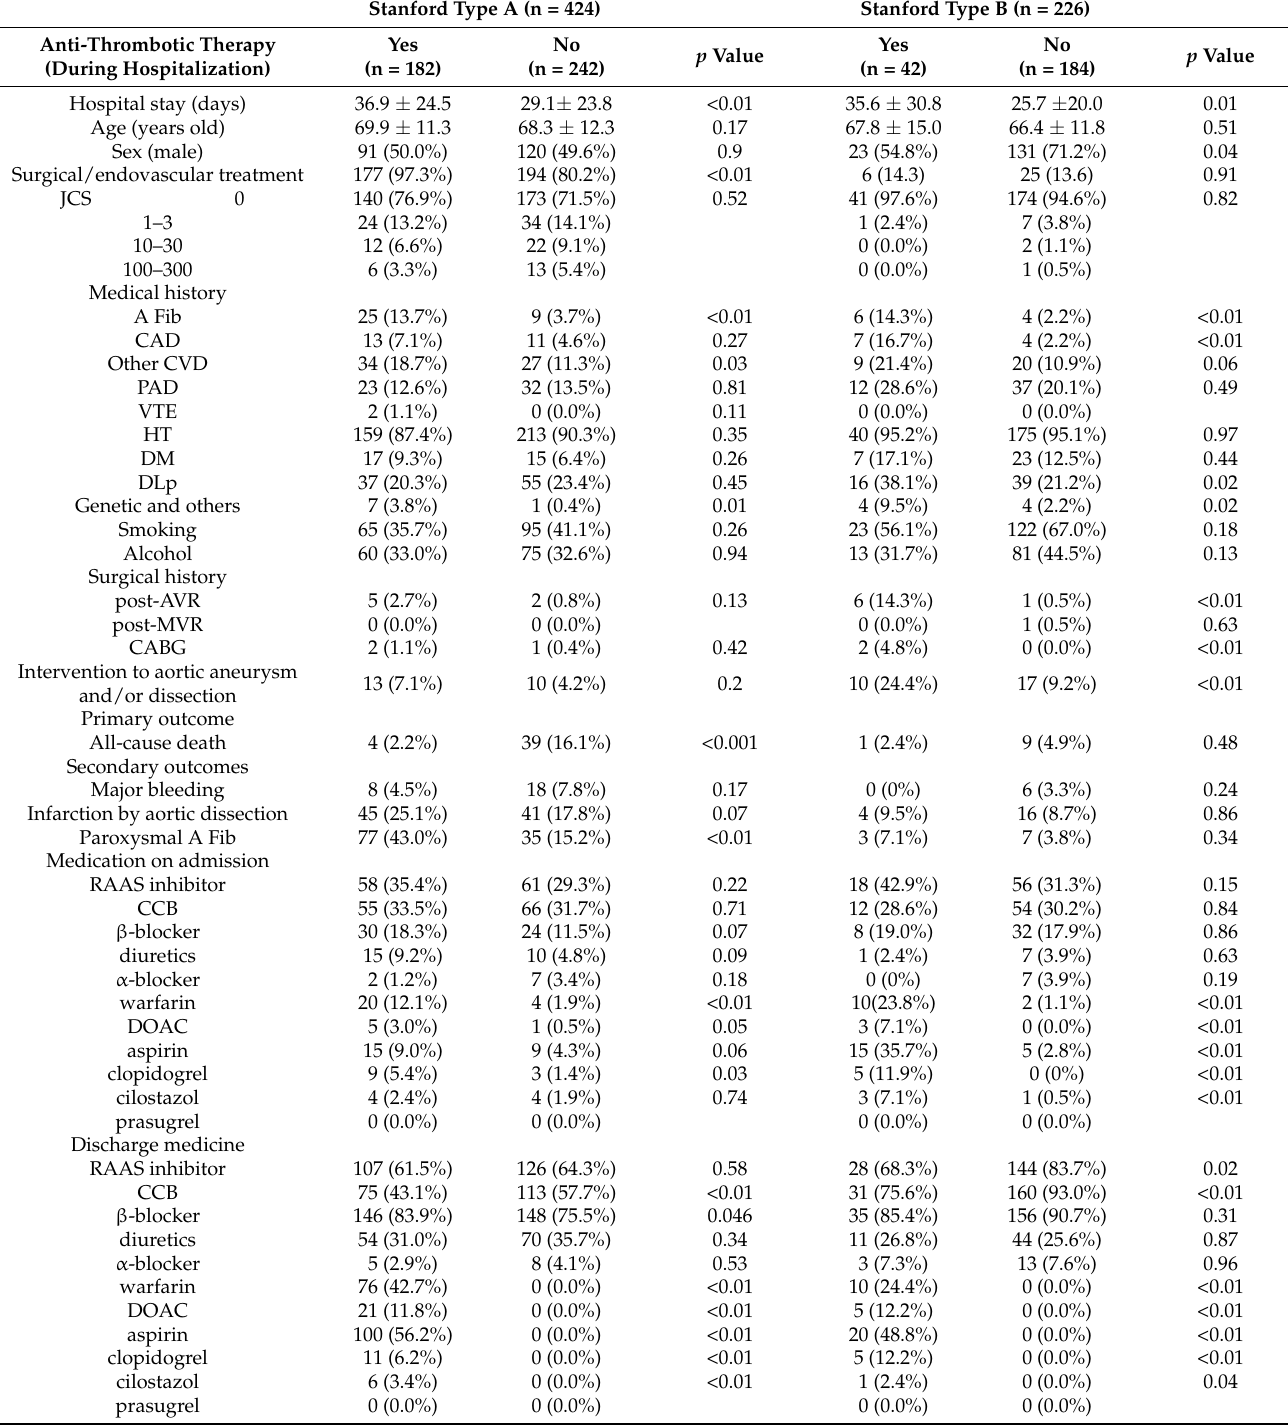
Table 6. Clinical characteristics of HOSPITALIZED acute aortic dissection with and without anti- thrombotic